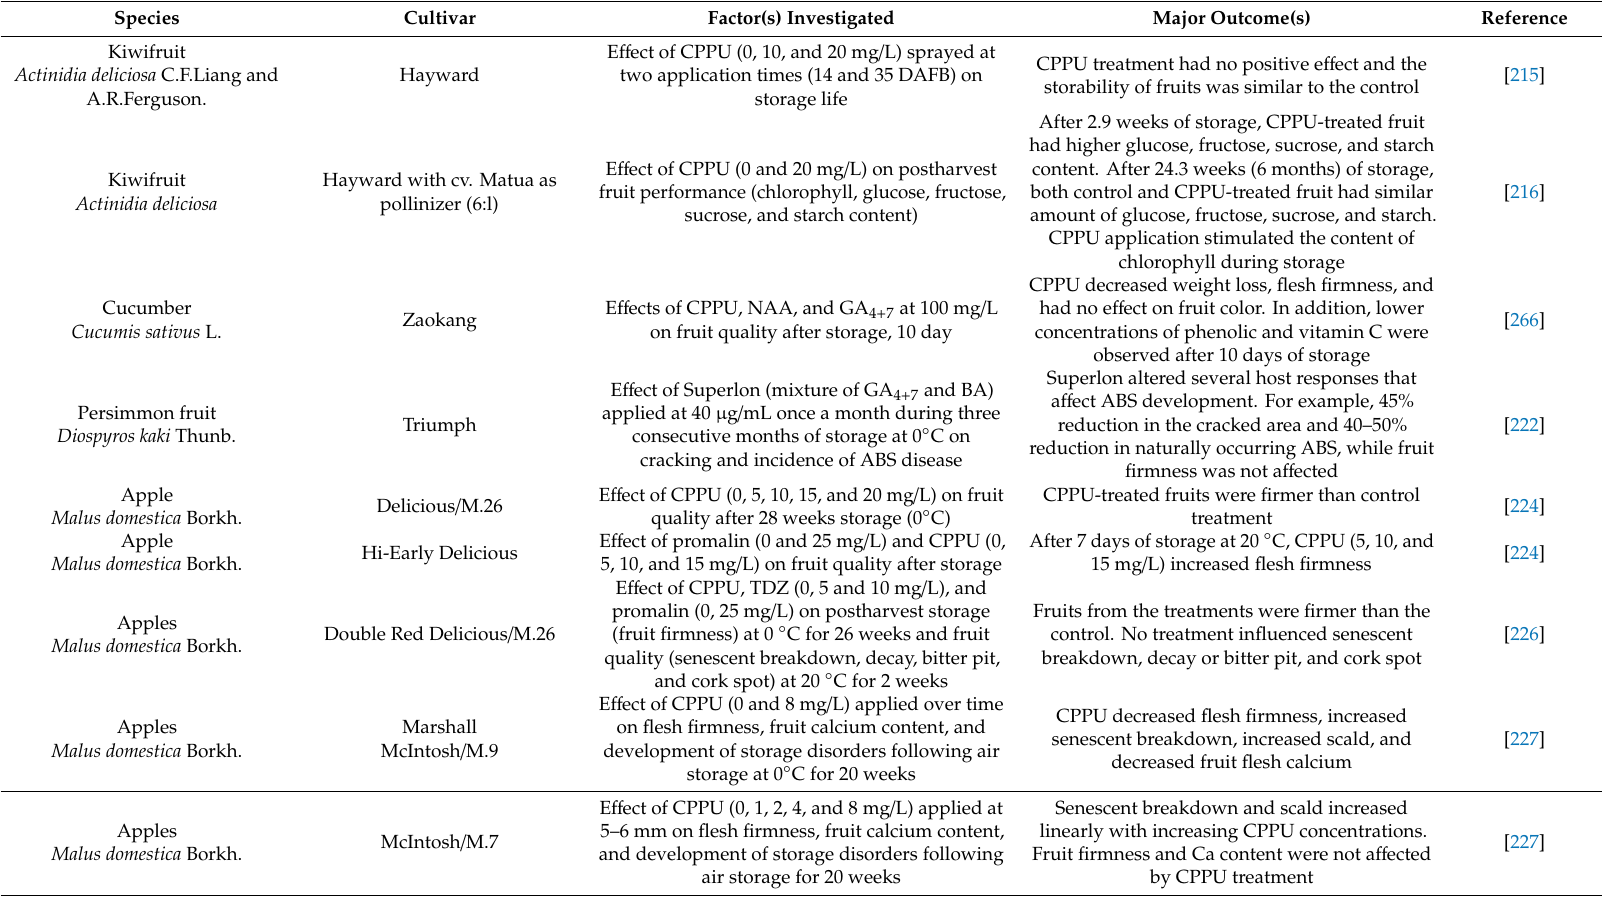
Table 6. E ff ects of preharvest application of cytokinins on postharvest quality of horticultural fruits. Species Cultivar Major Outcome(s)